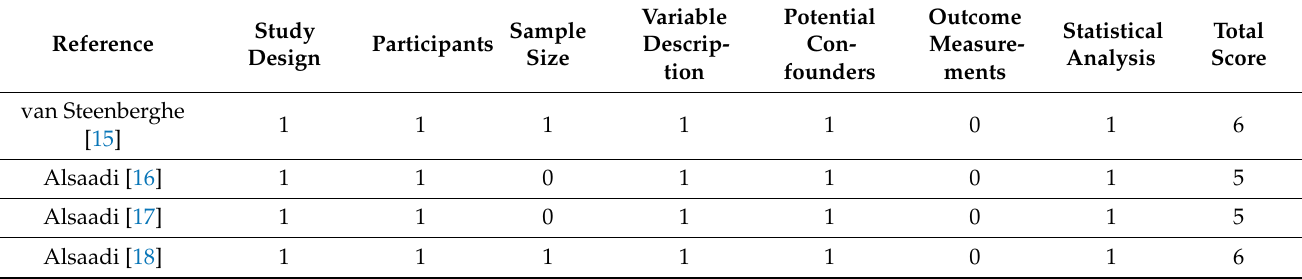
Table 3. Risk of bias